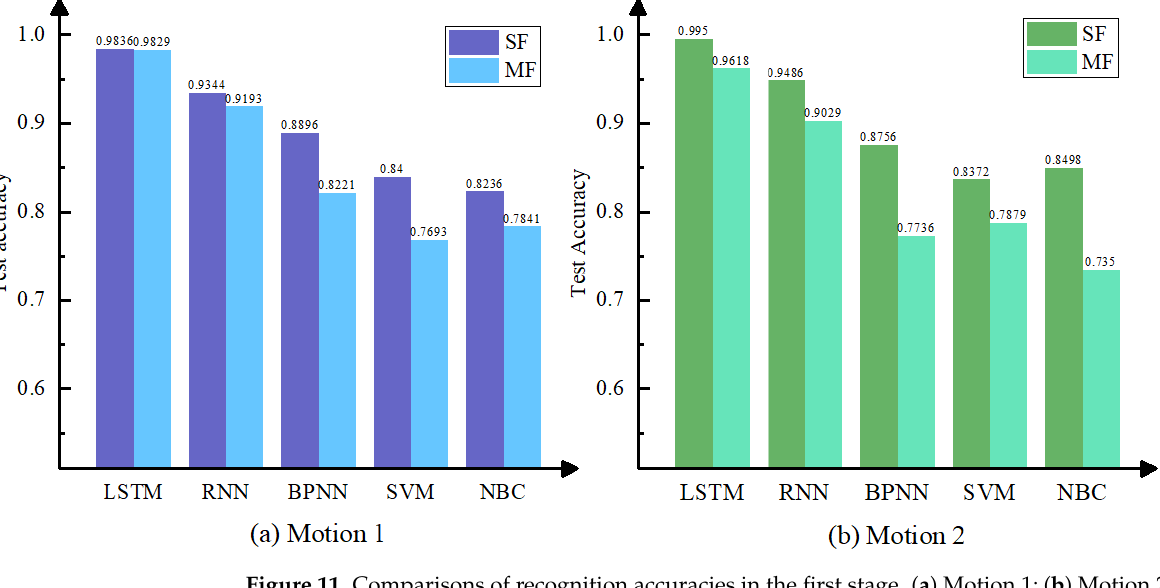
Table 6. The overview of joint fault types. Label